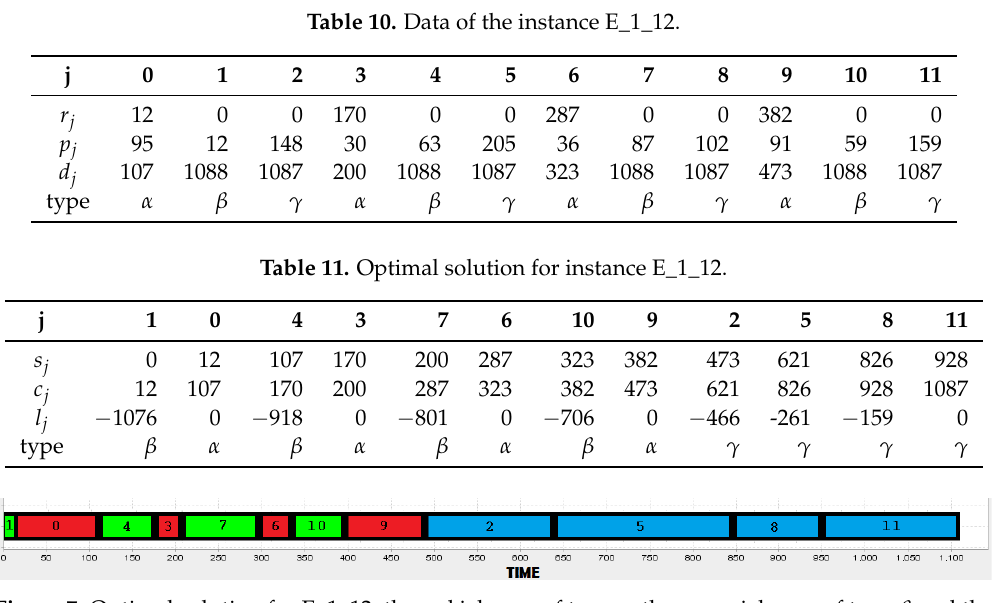
Figure 7. Optimal solution for E_1_12, the red jobs are of type α , the green jobs are of type β and the blue jobs are of type γ